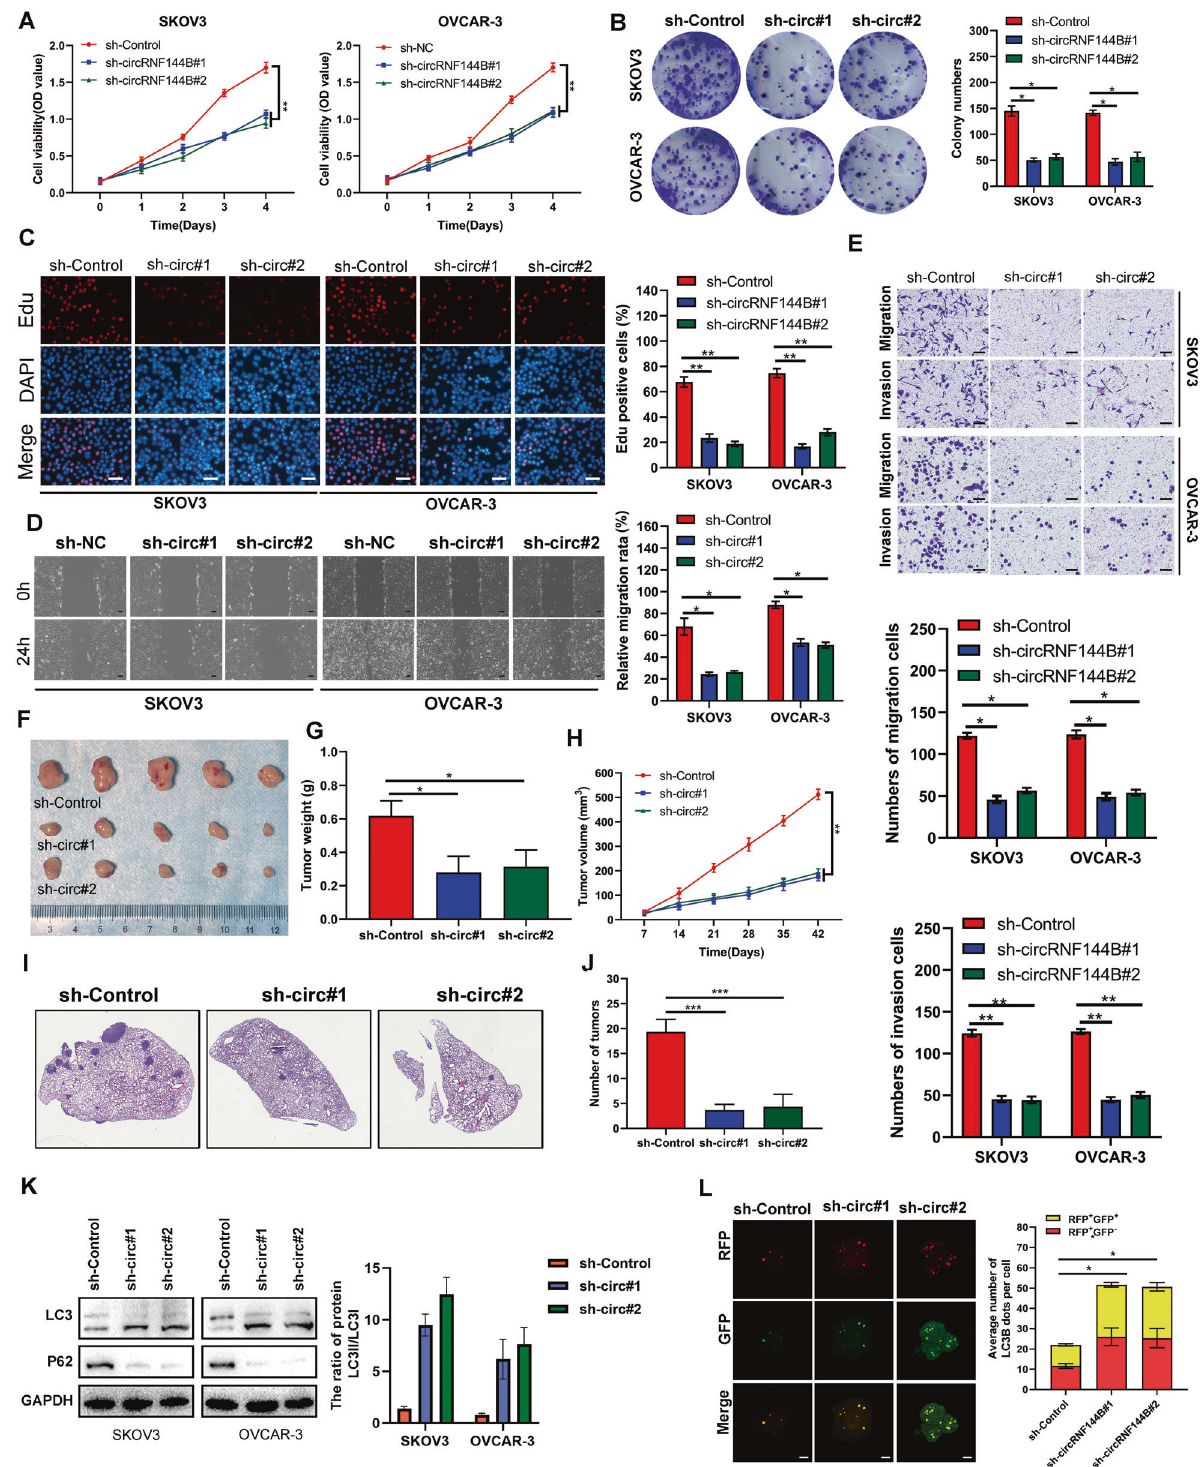
Fig. 3 Inhibition of circRNF144B reduced OC cell proliferation and mobility, as well as increased autophagy. A CCK-8 results indicated that circRNF144B knockdown inhibited the cell viability of SKOV3 and OVCAR-3. B Colony formation assay indicated that circRNF144B knockdown inhibited cell colony formation in SKOV3 and OVCAR-3 cells. C EDU positive rate was reduced in SKOV3 and OVCAR-3 cells with circRNF144B knockdown. Scale bar, 100 μ m. D Wound healing assay was used to detect the effects of circRNF144B knockdown on SKOV3 and OVCAR-3 cell migration. Scale bar, 50 μ m. E Transwell assay was used to detect the effects of circRNF144B knockdown on SKOV3 and OVCAR-3 cell invasion. Scale bar, 50 μ m. F – H The volume and weight of tumor tissues derived from SKOV3 cells with circRNF144B knockdown and control SKOV3 cells. I-J Number of metastatic foci in the lung tissues from the mice injected with SKOV3 cells with circRNF144B knockdown and control SKOV3 cells. K Western blot was used to detect the expression of LC3 and P62 in SKOV3 and OVCAR-3 cells after circRNF144B knockdown. L Confocal microscopy was used to detect the number of autophagosomes and autophagolysosomes in SKOV3 cell after circRNF144B knockdown. Scale bar, 25 μ m. *, P < 0.05; **, P < 0.01; *** , P < 0.001. Cell Death and Disease (2022)